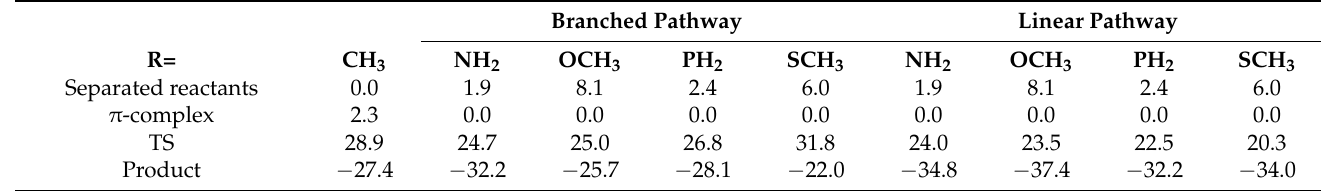
Figure 4. Transition state geometries for the methyl transfer from [Cu(CH 3 ) 2 ] - to alkynes of the form R-C ≡ C-CH 3 . Table 2. Relative free energies (kcal · mol − 1 ) of infinitely-separated reactants, π -complexes, transition states and products of the addition of [Cu(CH3)2] - to alkynes of the form R-C ≡ C-CH 3 . For each alkyne, all energies are shown relative to the energy of its most stable π -complex. Single-point energies were computed at the PBEPW91/6-311G(2d,p)//6-31G(d), including solvation effects in THF and zero-point and vibrational effects at 223 K.